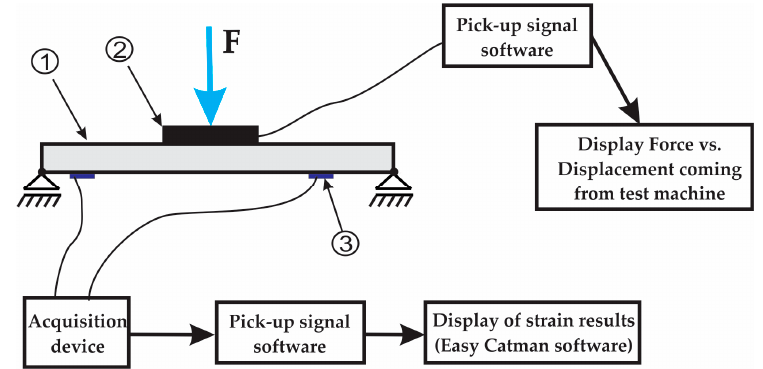
Figure 5. Scheme stand the test of laminated composite plate: 1-manhole cover tested; 2–Punch used to apply the force; 3–strain gauges.